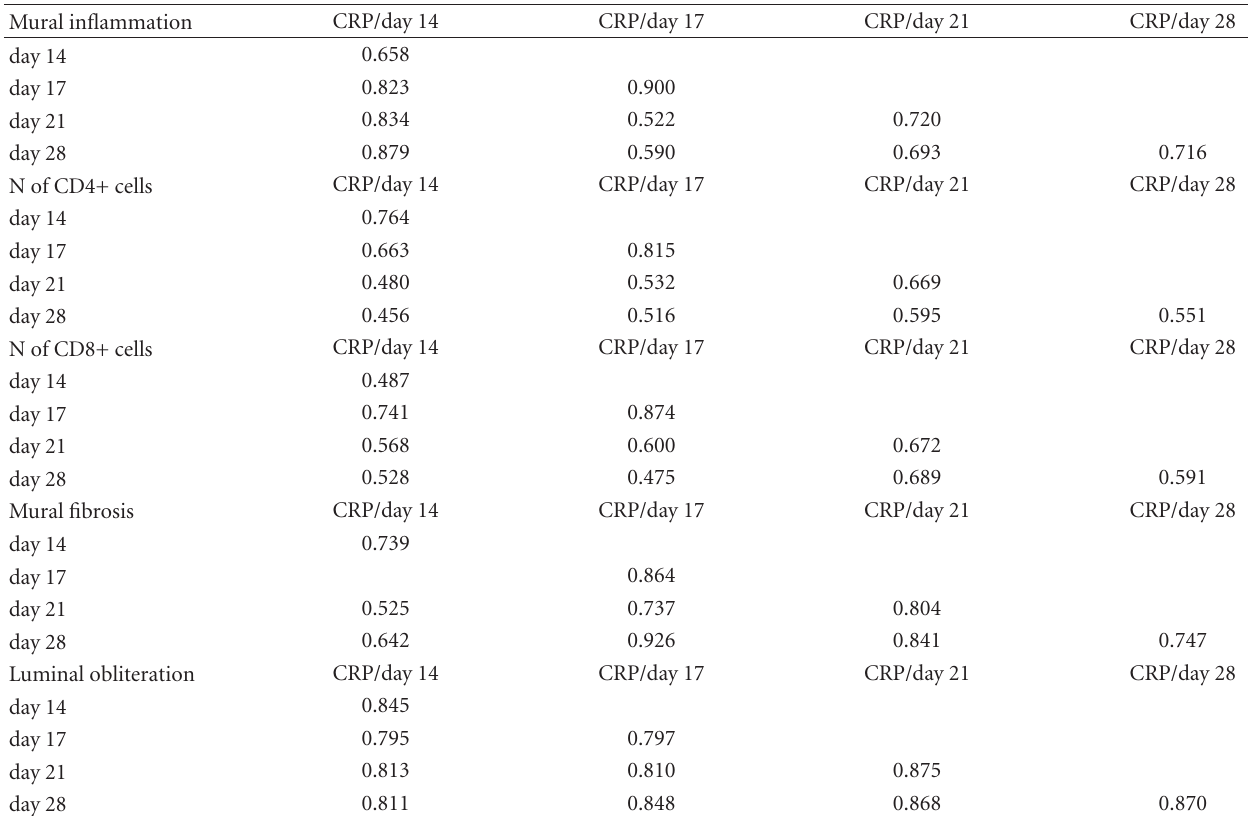
Table 2: Correlations (R) to the grade of bronchial wall CRP. R is given for assessment points with statistical significance ( P < . 05). The grade of CRP expression in the bronchial wall turned out to correlate to the inflammatory alterations and bronchial remodeling processes. Correlations are given from the follow-up day 14 onward. On the follow-up day 14 onward, grade of CRP expression was significantly ( P < . 0001) more intense in allografts than in